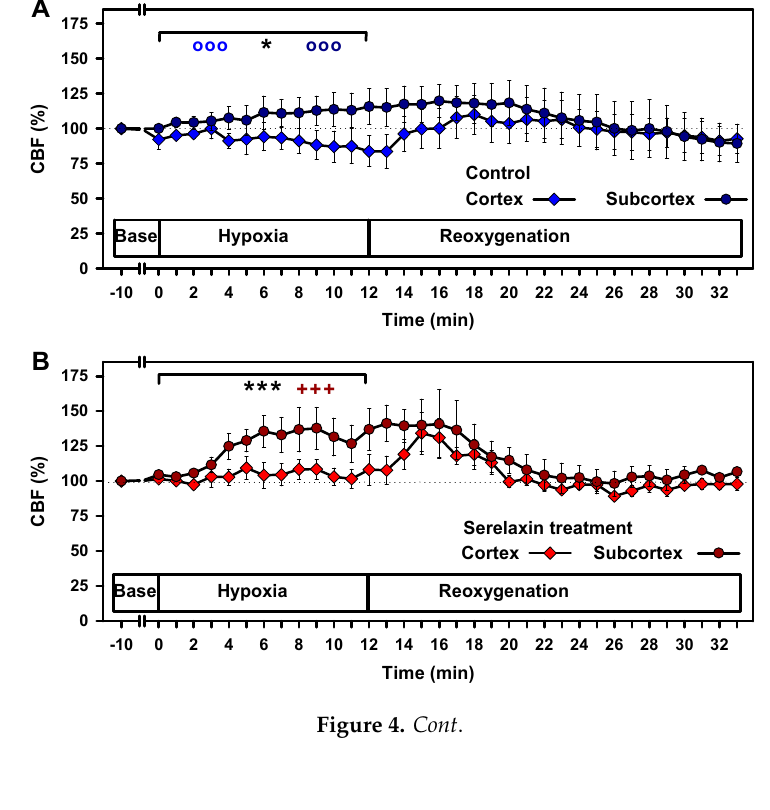
Figure 4. Effects of hypoxia and reoxygenation on cortical and subcortical cerebral blood flow (CBF). Comparison of cortical and subcortical CBF in the control group ( A ) and under serelaxin treatment ( B ). Comparison of controls and serelaxin treatment for the ( C ) cortex and ( D ) subcortex. Linear mixed models were separately calculated for hypoxia and reoxygenation. Statistically significant effects were found during hypoxia: ooo, p < 0.001 for the comparison of the control group with baseline values. +++ p < 0.001 for the comparison of the serelaxin-treated group with baseline values.